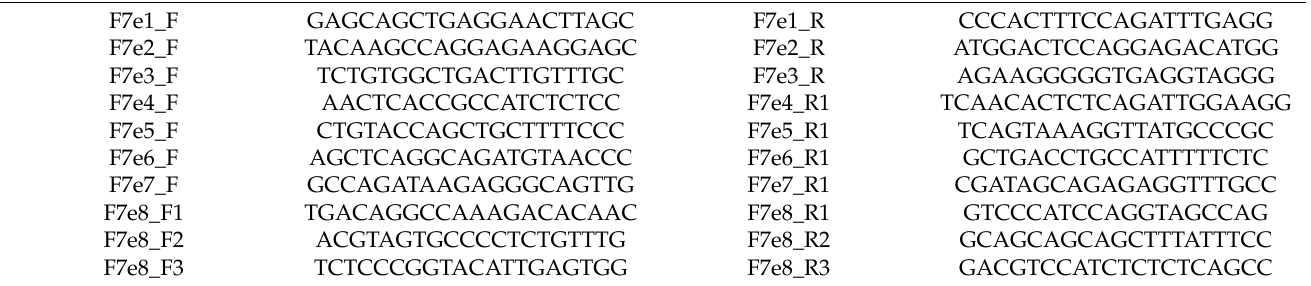
Table 1. Names and sequences of the forward and reverse primers (5 (cid:48) –3 (cid:48) ) used to amplify the eight exons of the F7